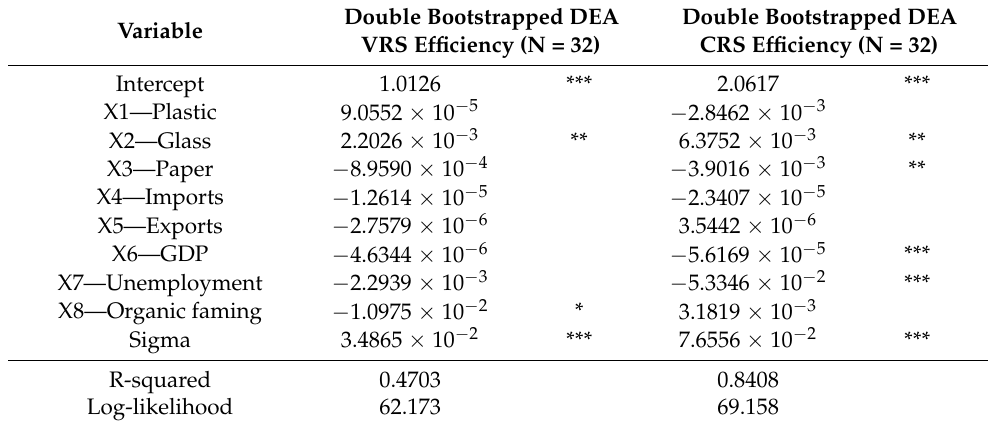
Table 5. Results of truncated regression models—estimates and